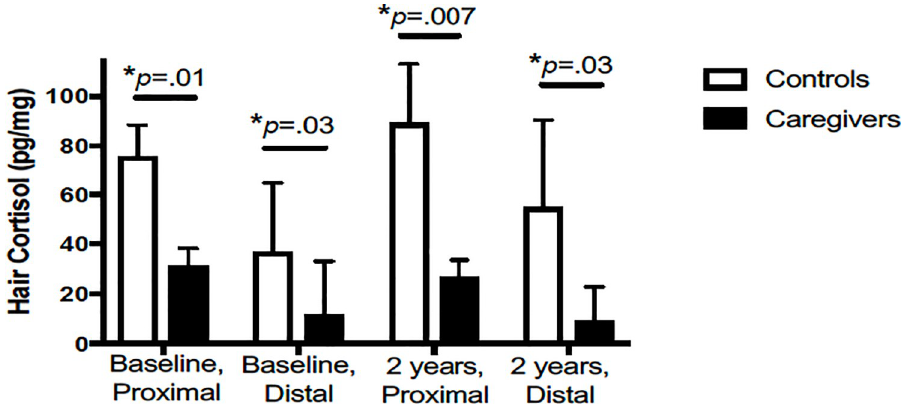
Fig 1. Group differences in hair cortisol at baseline and 2 years. Baseline data are presented from analysis of analysis of covariance (ANCOVA) adjusted for baseline BMI (proximal segment: F (1,163) = 6.81, p = .01; distal segment: F (1,154) = 4.65, p = .03). Two year data are presented from ANCOVA adjusted for 2 year BMI (proximal segment: F (1,105) = 7.58, p = .007; distal segment: F (1,102) = 9.33, p = .03). The raw (non log-transformed) adjusted mean+SE for hair cortisol is shown for caregiver (filled bar) and controls (open bar) at each time